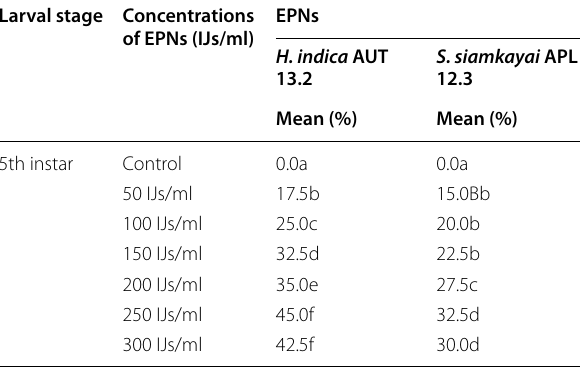
In each column, the mean followed by a common letter is not significant. Mean separated by Duncan multiple range tests at 5% level